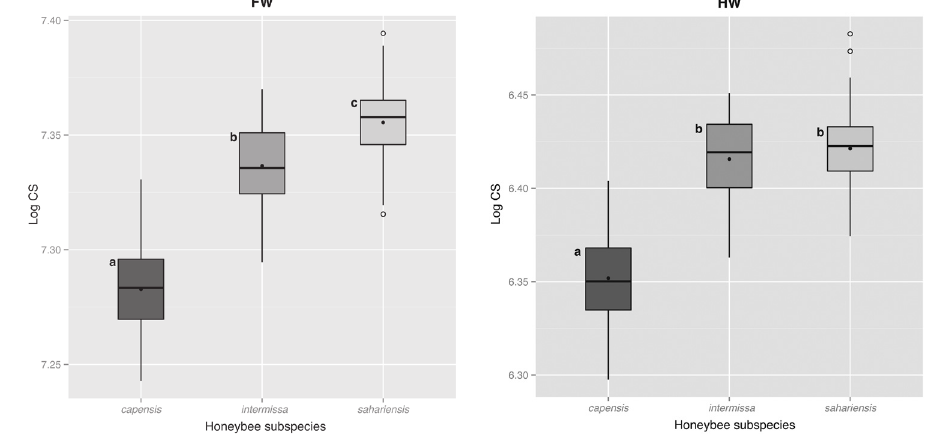
Figure 2. Box plots of the logarithm of wing centroid size for each subspecies of Apis mellifera